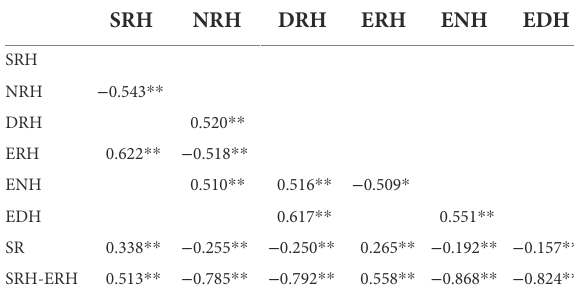
TABLE 17 Correlation between the types of internal and external regulation Health Psychology ( n =